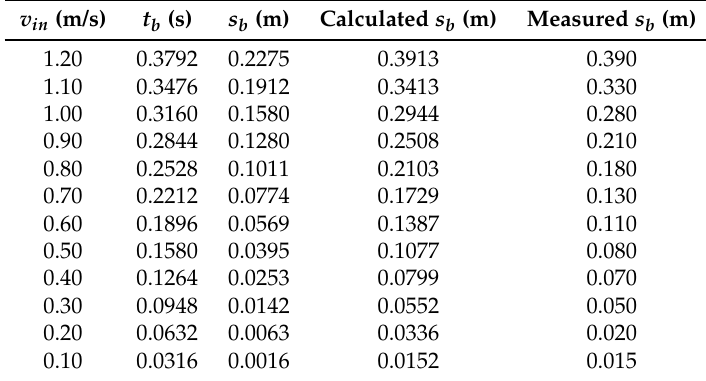
Table 3. Results of breaking distance calculated vs. measured